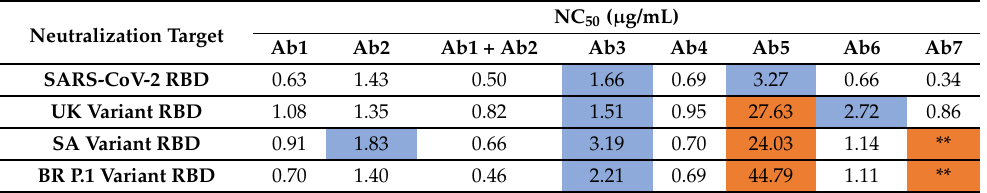
Table 2. NC 50 summary table. Semi-logarithmic curve fitting was used to extrapolate the NC 50 values. For antibody Ab5, the range of 0.5~10 µ g/mL was used for curve fitting. For the other six antibodies and the combined antibodies, the range of 0.1~10 µ g/mL was used for curve fitting. (Note 1) Strong neutralizing activity: NC 50 < 1.5 µ g/mL. Moderate neutralizing activity (blue): 1.5 µ g/mL ≤ NC 50 < 15 µ g/mL. Weak or no neutralizing activity (orange): NC 50 ≥ 15 µ g/mL. (Note 2) ** indicates that the NC 50 value was not calculated due to the flat nature of the curve and the very weak neutralizing